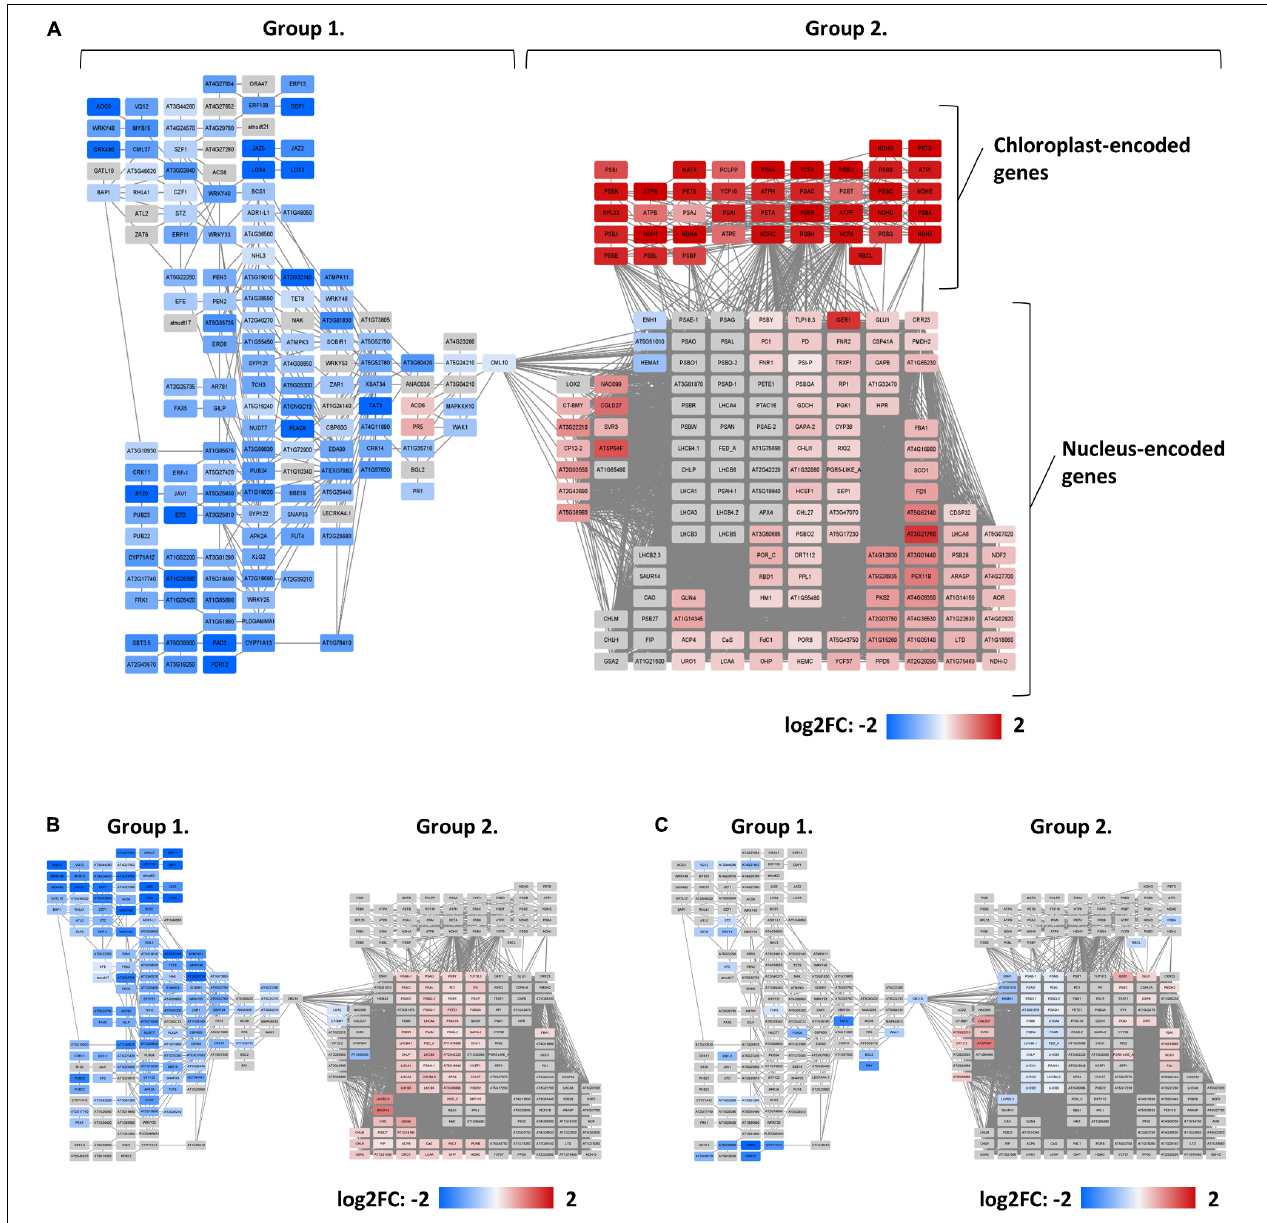
FIGURE 3 | Co-expression networks of genes that were differentially expressed between genotypes or treatments. (A) Col-Fe, (B) erf109 -regulon, and (C) erf109-Fe . Log2-fold change of DEGs are labeled by color: gray, no significant changes; red, up-regulated; blue,